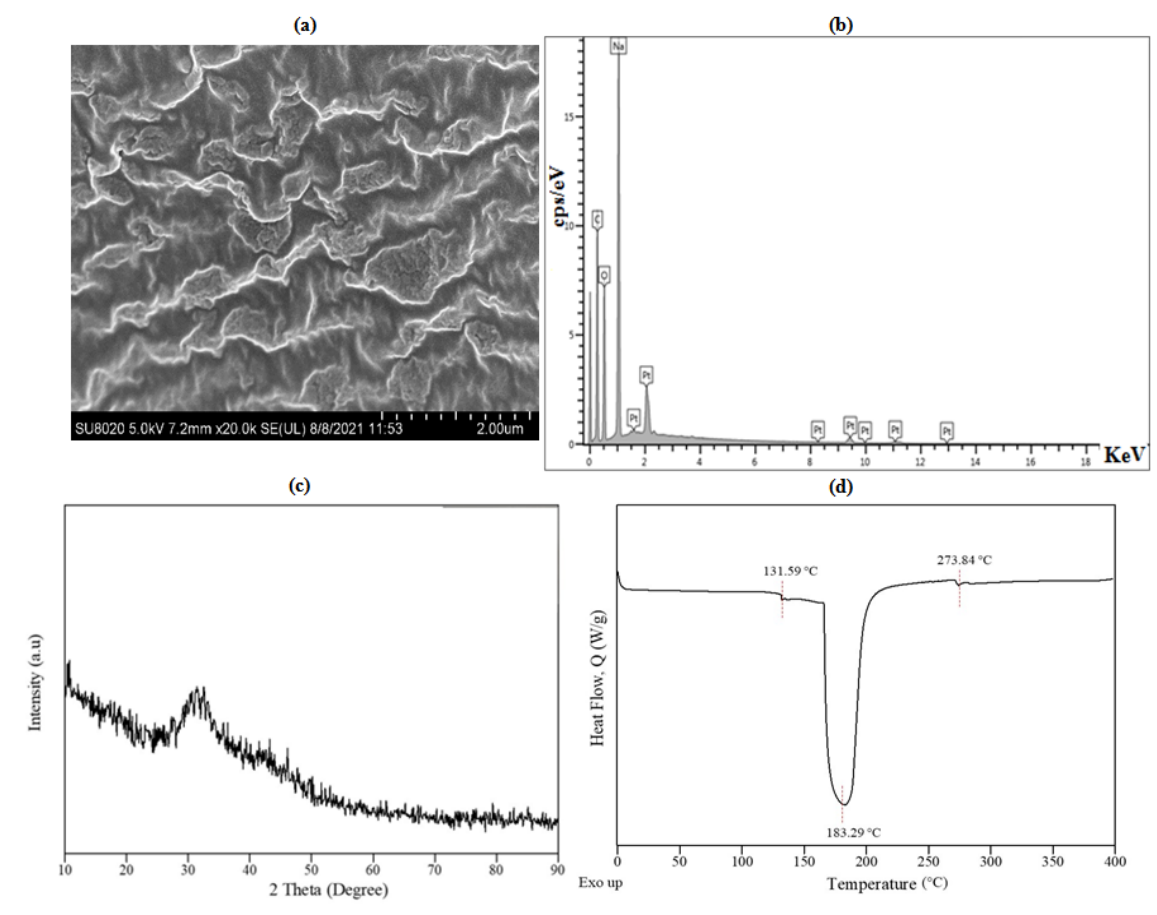
Figure 8. Analysis of S-SAP showing ( a ) FESEM micrographs at 20.0 k magnification, ( b ) EDX spectra for elemental composition of S-SAP, ( c ) XRD diffractogram, and ( d ) DSC thermogram.